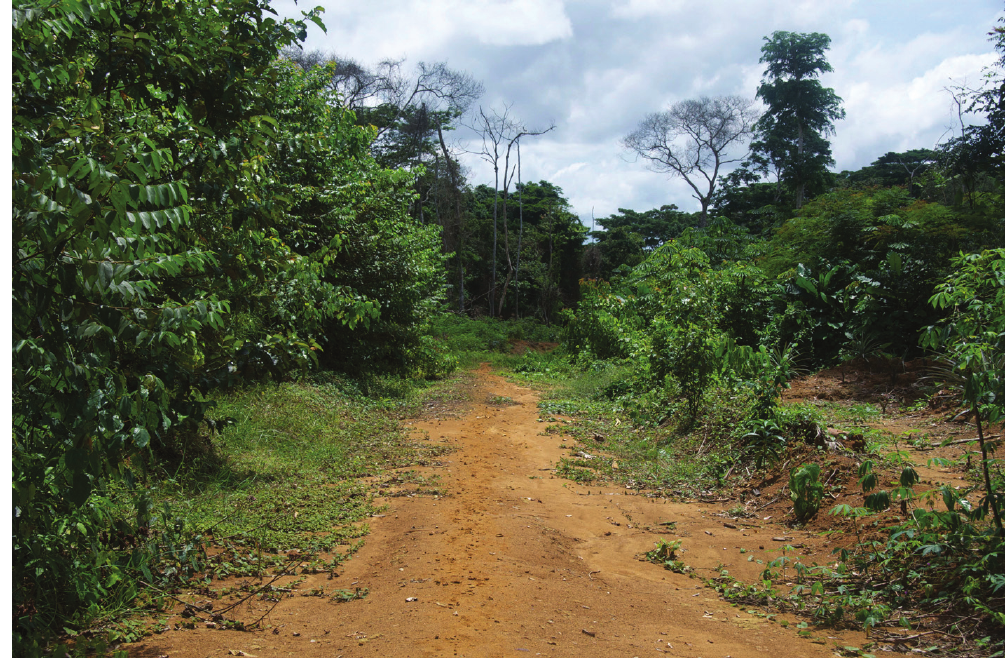
Fig. 6. Natural habitat of Thiratoscirtus lamboji sp. nov., 122 km south of Makokou, Gabon (photo by a.